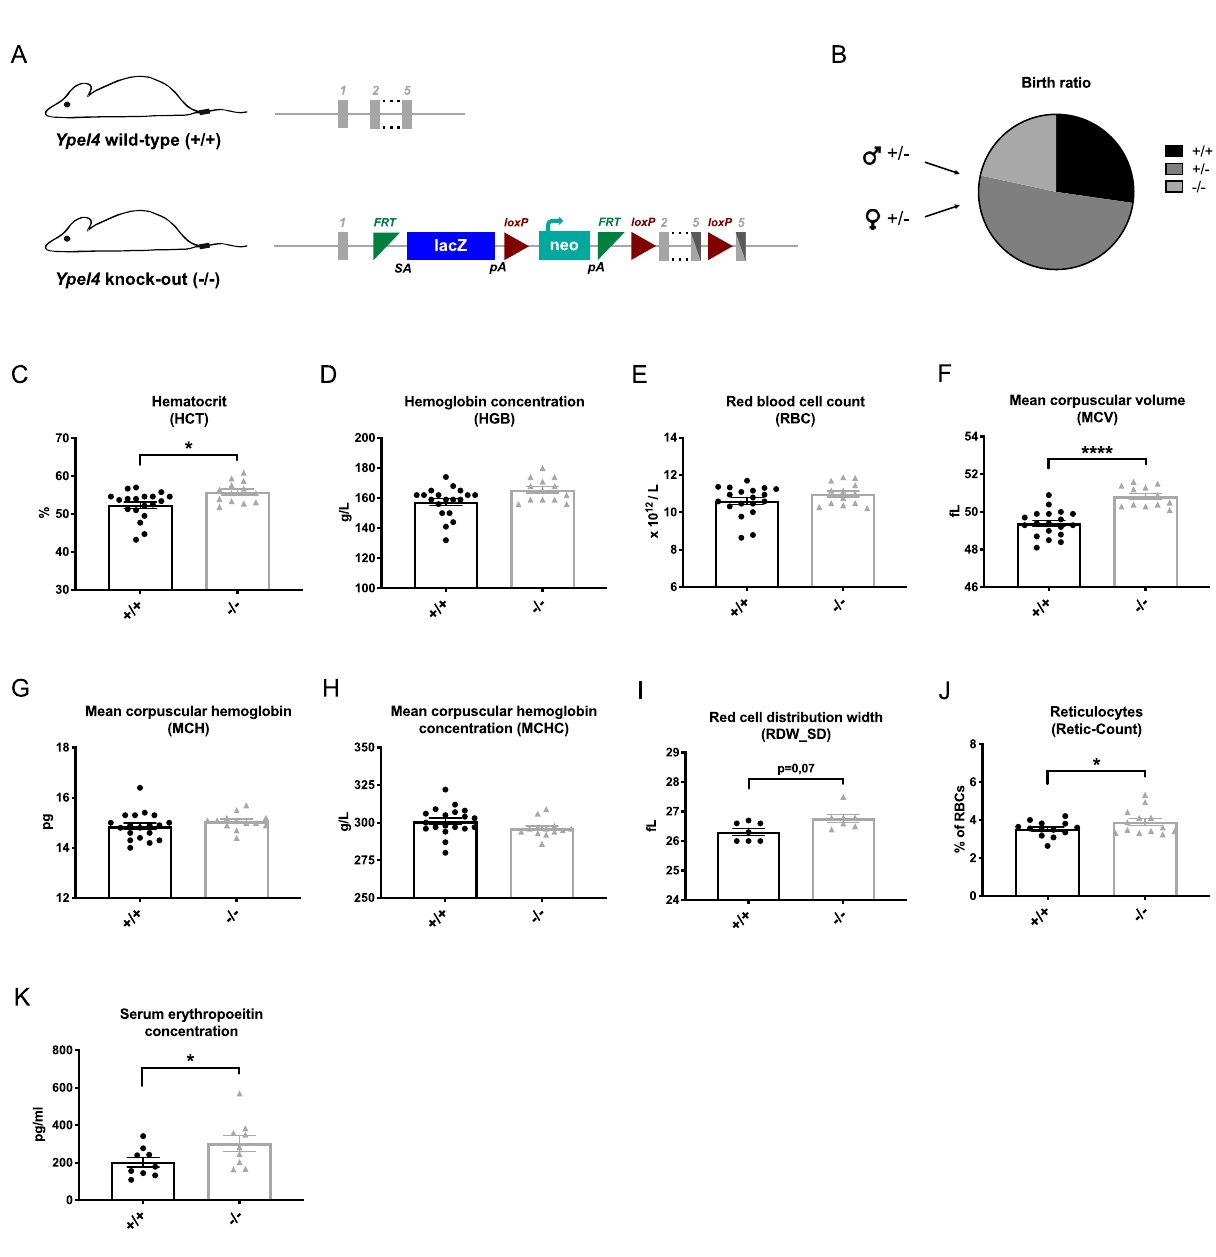
straight-forward false positive discoveries (Supplementary Figure S2E–G). To analyze extra-medullary hematopoiesis, spleens were examined by weight which showed no significant difference in Ypel4 -null mice (Supplementary Figure S2H). To investigate extra-medullary erythropoiesis in